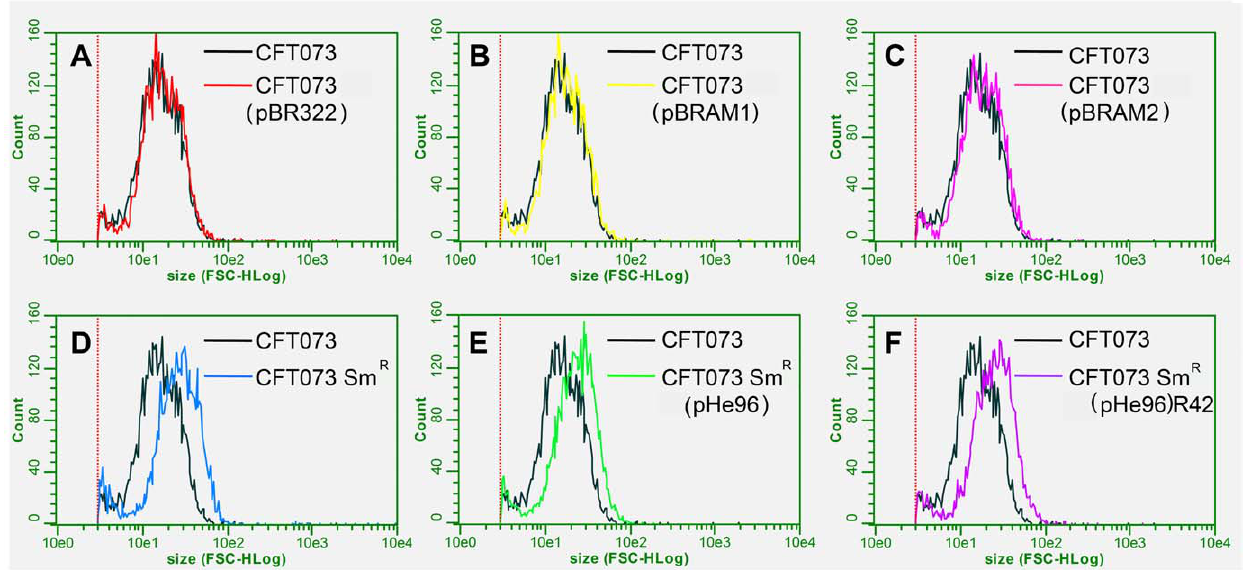
Figure 1. Cell size measured by flow cytometry for the strains of the two isogenic systems. Each graphic compares size measurement for bacterial cell populations consisting of the reference susceptible strain E. coli CFT073 (in black) and of the tested strain : E. coli CFT073(pBR322) ( qnr - negative) in red (part A), E. coli CFT073(pBRAM1) ( qnrA3 -positive) in yellow (part B), E. coli CFT073(pBRAM2) ( qnrA3 -positive) in pink (part C), E. coli CFT073-Sm R ( qnr -negative) in blue (part D), E. coli CFT073-Sm R (pHe96) ( qnrA3 -positive) in green (part E) and its variant R42 in purple (part F). Measurements were made separately, not in a competitive assay.